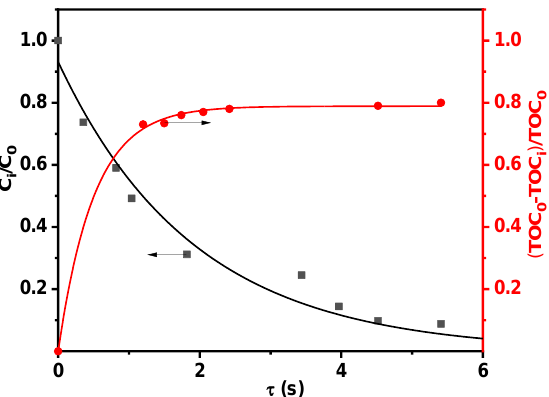
Figure 9. Degradation ( – ⬛ – ) and mineralization ( – ● – ) performance under the DBD treatment using the TiO 2 -PAMMH catalyst. Processing conditions: initial concentration of RhB is 40 mg/L, carrier gas flow rate is 0.5 L/min, the discharge current is 3.2 mA, and discharge current frequency is 500 Hz; discharge power is 20 W/cm 3 .